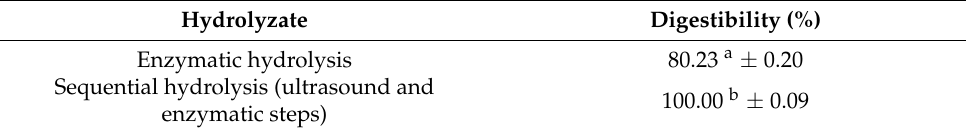
Table 8. In vitro protein digestibility of CF